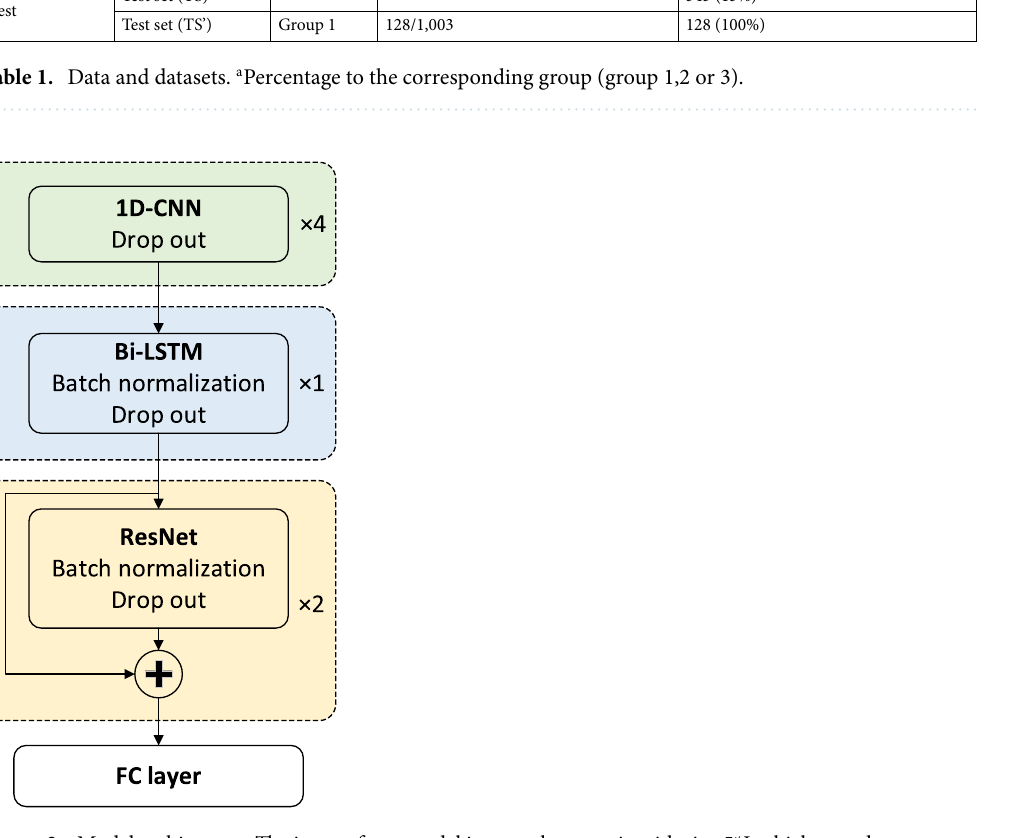
Figure 3. Model architecture. The input of our model is a one-hot matrix with size 5*L which encodes a subsequence of length L. This matrix is then transformed into a matrix with size C*L and U*L by the 1D-CNN and Bi-LSTM layers, respectively. In fact, every base in the input RNA is encode by U units. Then, every base, encode by U units, is transformed by the following FC layers, resulting in an output with a size 1*L